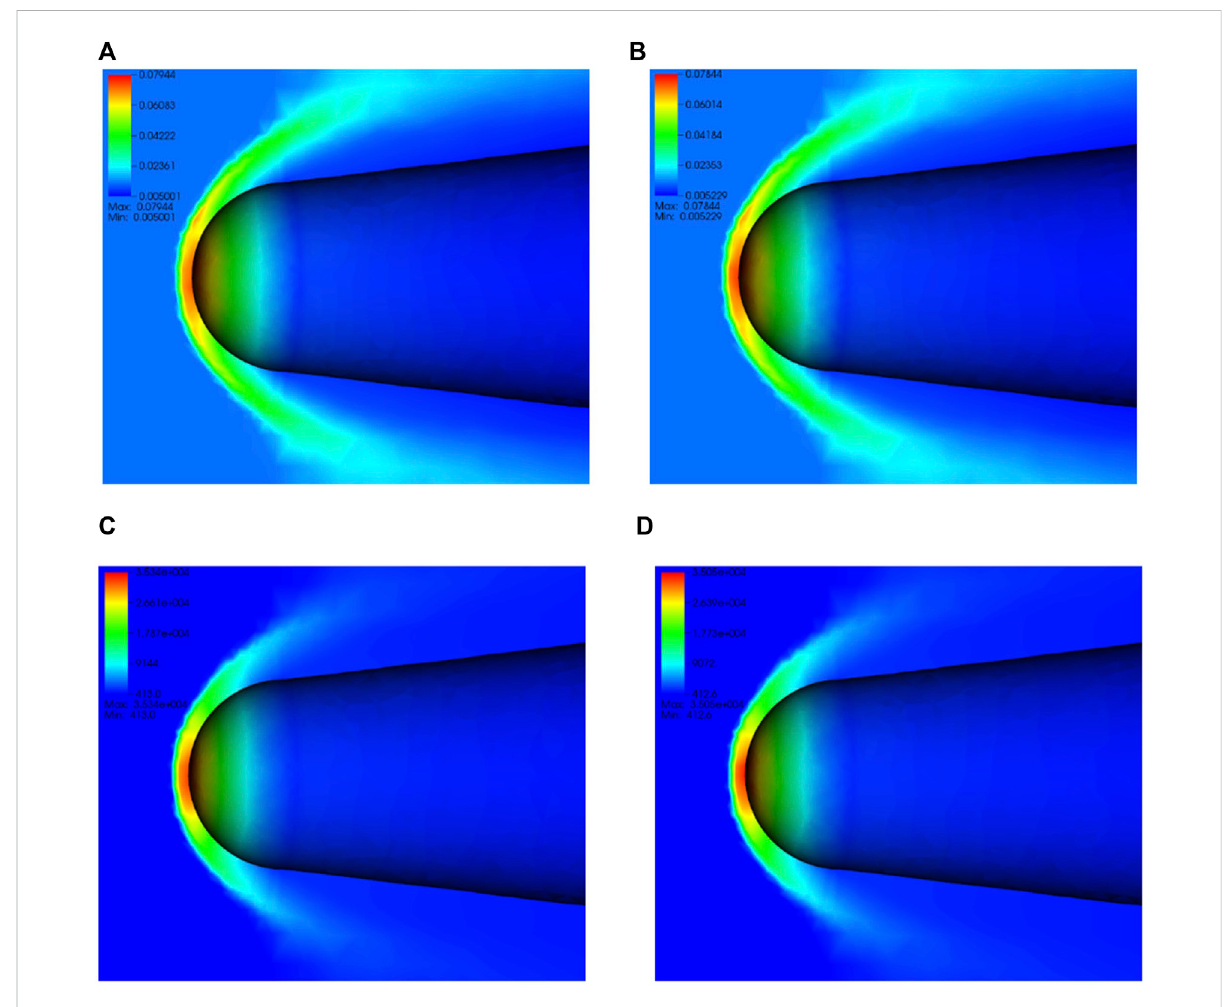
FIGURE 8 Computed fl ow distribution of (A) density with P 1 Q 1 element, (B) density with P 2 Q 2 element, (C) pressure with P 1 Q 1 element and (D) pressure with P 2 Q 2 element for the blunt cone